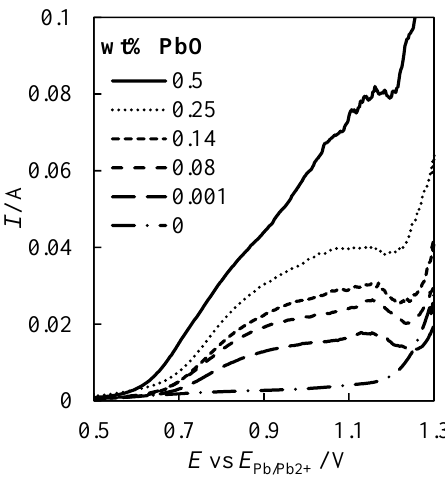
Figure 7. CVs in the PbCl 2 melt with a different expected PbO content at a potential sweep rate of 0.1 V s −1 and a temperature of 520 ° C.